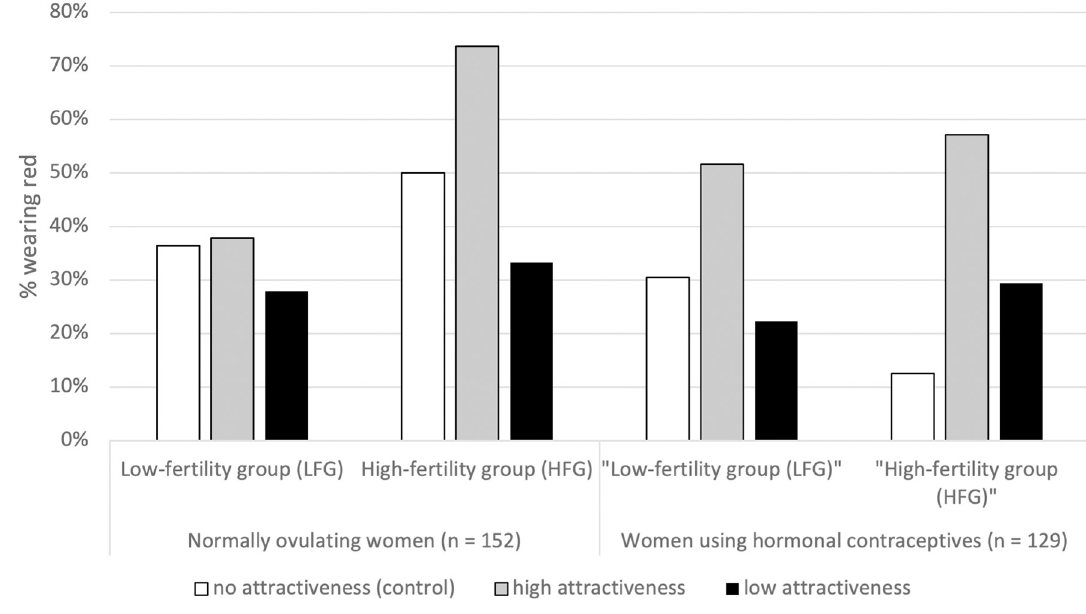
Fig 1. The effects of the physical attractiveness of the male research assistant and “fertility” in normally ovulating women versus women taking hormonal contraceptives.